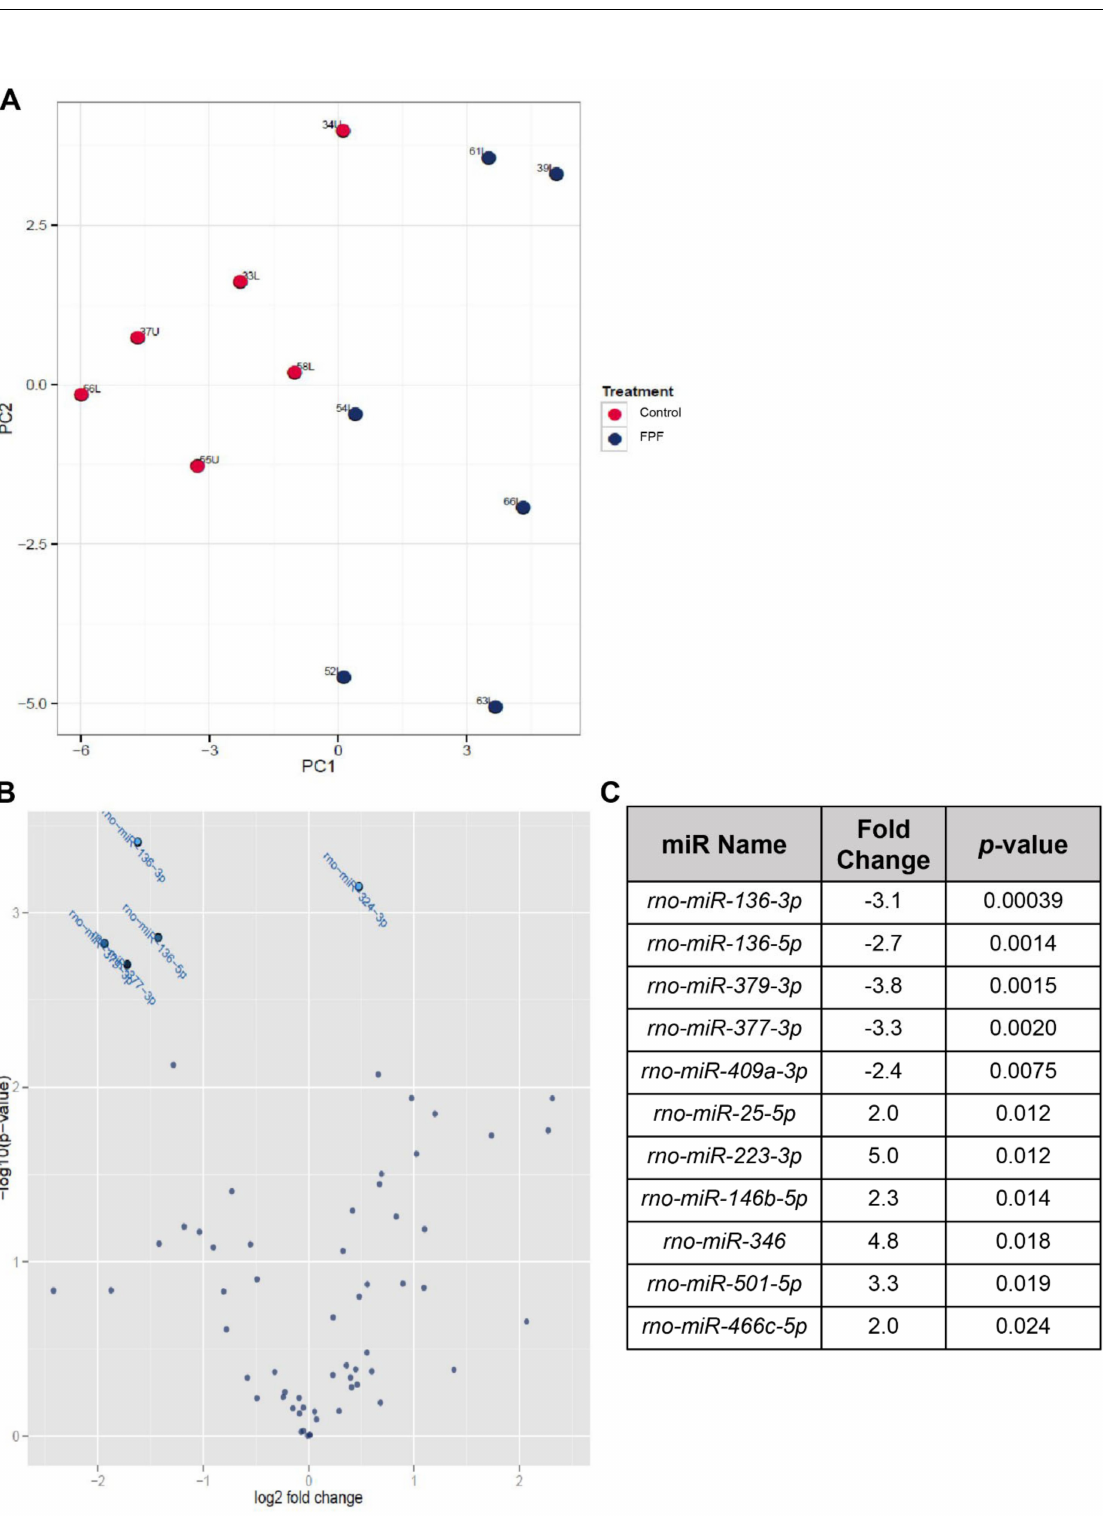
Figure 8. Transcriptional regulation is modulated by FPF treatment. MicroRNA profiling was performed on flash-frozen wound tissues using LNA-enhanced, SYBR Green based miRNA qPCR. ( A ) Principal component analysis (PCA) showing the distance and relatedness between samples with miRs having the largest coefficient of variation. ( B ) Volcano plot showing the relationship between p-values and fold change in normalized expression between control and FPF-treated groups. ( C ) Most differentially expressed known miRs with fold change (FC) between control and FPF-treated groups ( N =